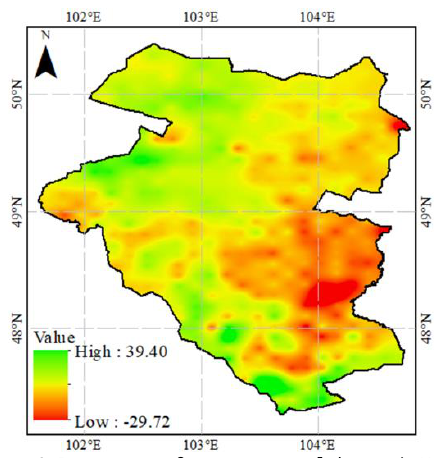
Figure 6. Percentage of average annual change in NDVI (June, July, and August of